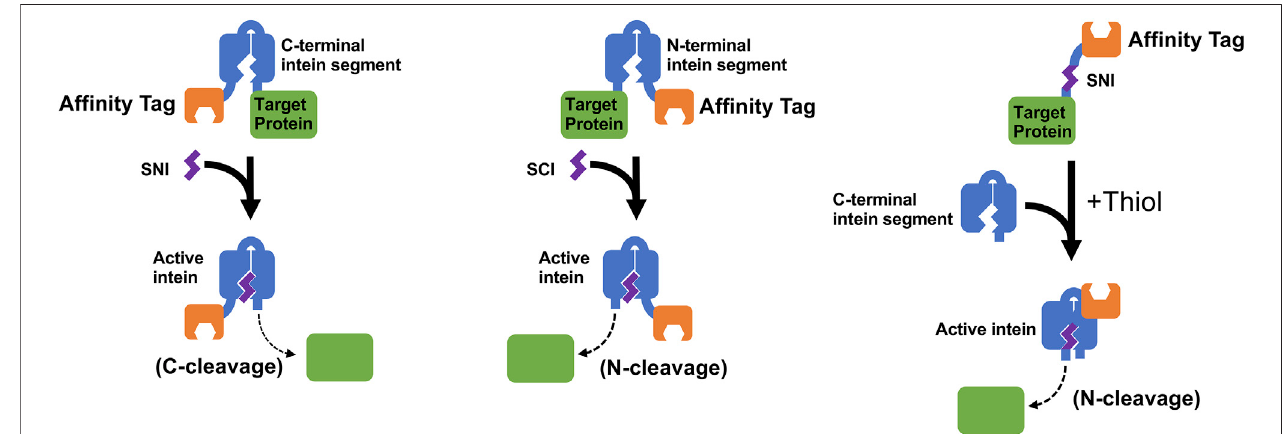
FIGURE 5 | This fi gure illustrates schemes of controllable protein cleavage using the SCI and SNI split inteins discussed in a patent fi led by scientists at Dalhousie University(Liuetal.,2013;PatentNo.:US8394604B2;prioritizedin2008, fi ledin2009andapprovedin2013).Therecombinantprecursorproteintypicallyconsistsofa TargetProtein,eithertheN-terminalinteinsegmentorC-terminalinteinsegment,andanoptionalAf fi nityTagforeasypuri fi cationoftheprecursorprotein.Cleavageatthe intein ’ s C-terminus or N-terminus can be triggered by the addition of the complementing Small N-intein (SNI) or Small C-intein (SCI), respectively, or by addition of the C-terminal intein segment to a smaller SNI Af fi nity Tag fusion as shown in the fi gure (Volkmann et al.,